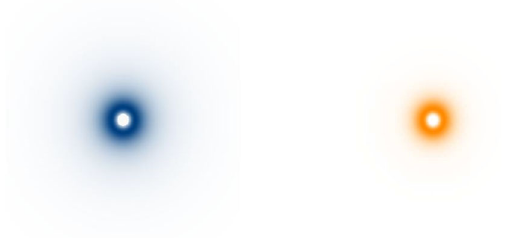
Fig. 6 The electric field in the plane (left, blue) with e = 1 and the energy density (right, orange) associated to the model in Sect. 3.2 for σ = 5 and k = 1. The intensity of the blue and orange colors increases with the increasing of the electric field and energy density, respectively